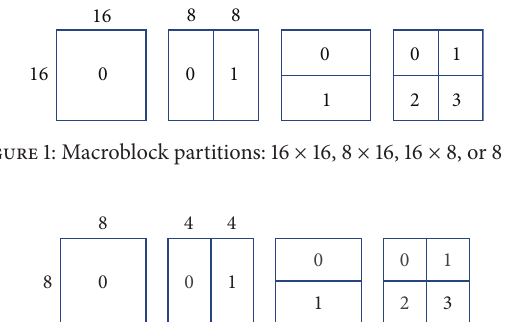
Figure 2: Macroblock subpartitions: 8 × 8, 4 × 8, 8 × 4, or 4 ×